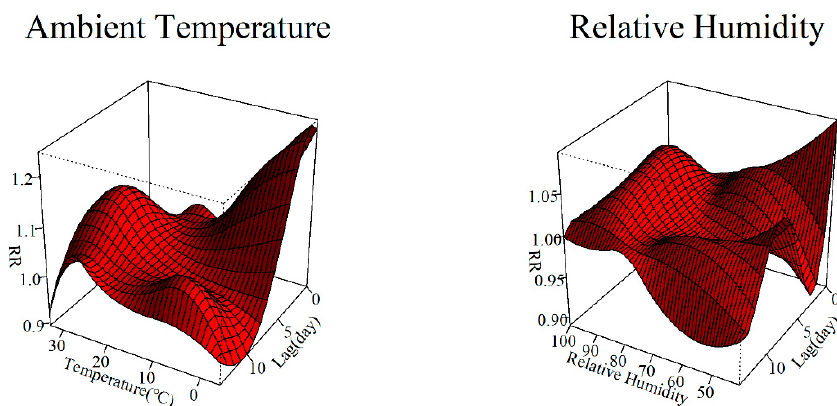
Figure 2. Three dimensional (3D) lag–response curves specific to ambient temperature and relative humidity.